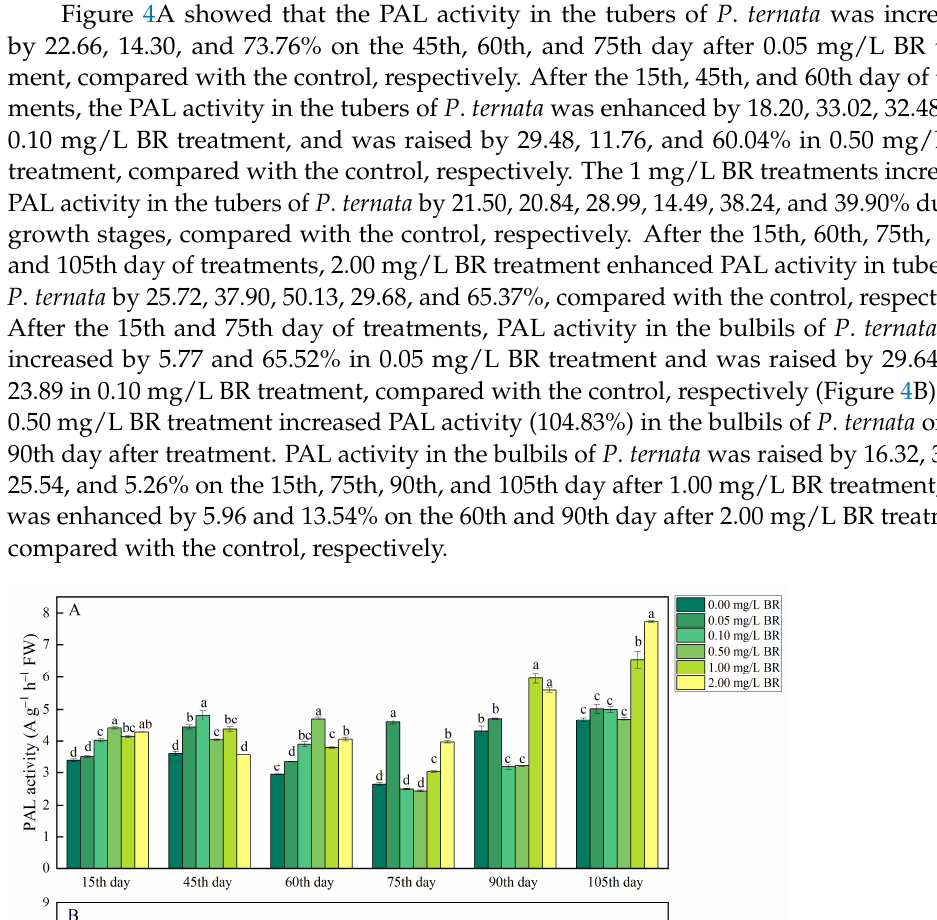
GS activity in the tubers of P . ternata by 12.72 and 14.87%, compared with the control, respectively. The 2.00 mg/L BR treatment enhanced GS activity (5.38%) in the tubers